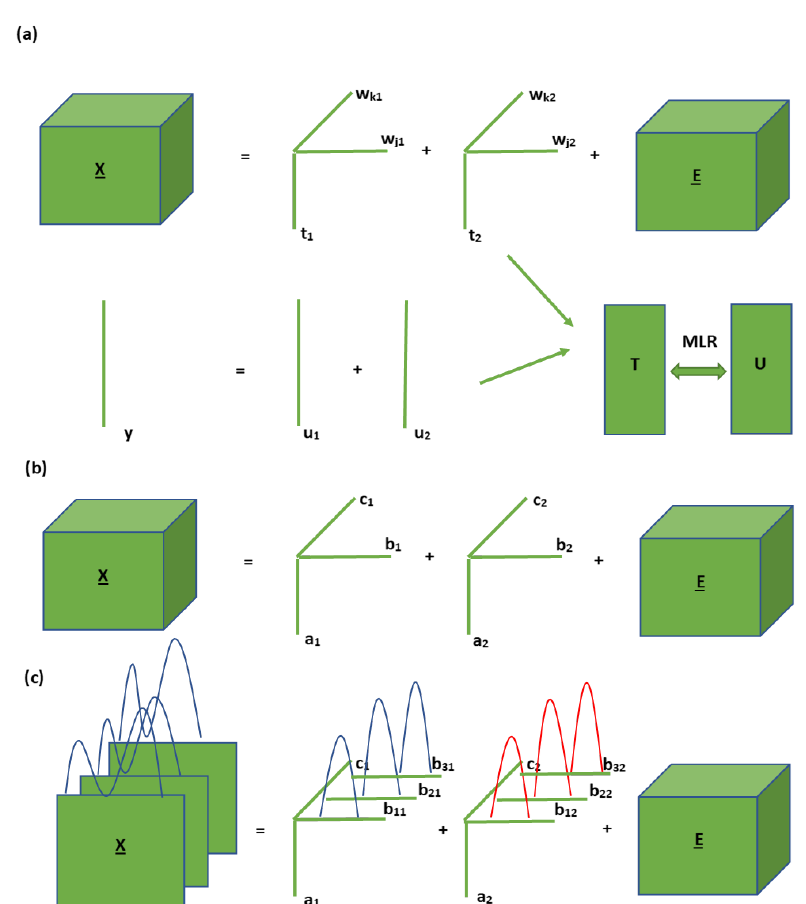
Figure 1. Graphical representation of the modeling process of: ( a ) N-way partial least square regression (N-PLS); ( b ) parallel factor analysis (PARAFAC) and ( c ) parallel factor analysis 2 (PARAFAC2) on three-way data with two components.